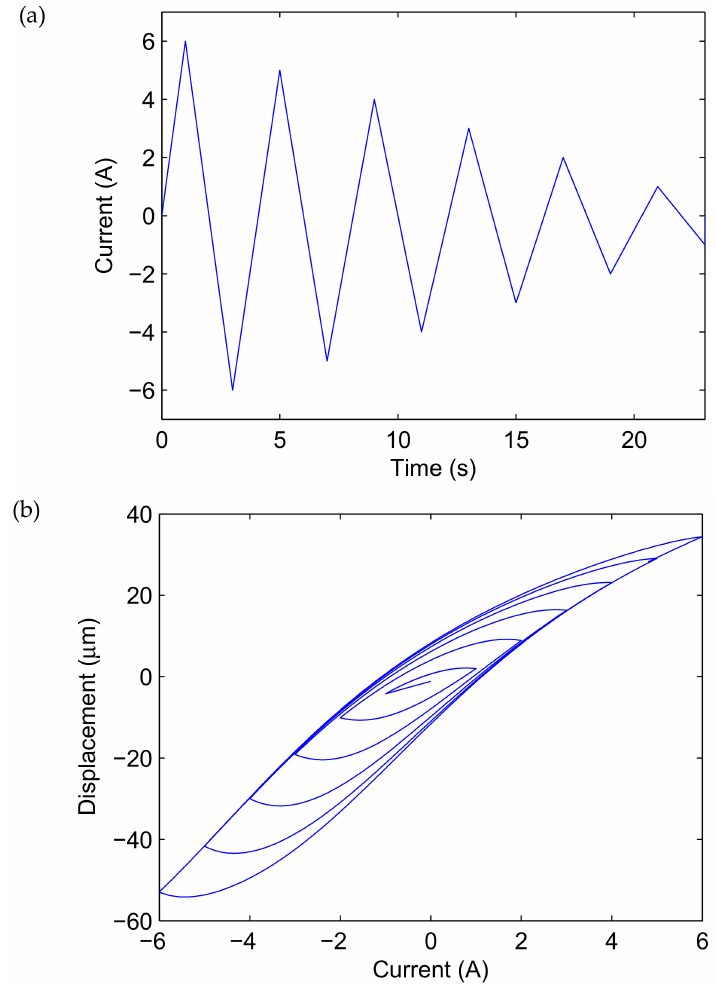
Figure 6. Tests of the magnetostrictive actuator under triangle excitation current: ( a ) the excitation current with di ff erent amplitudes and ( b ) the output